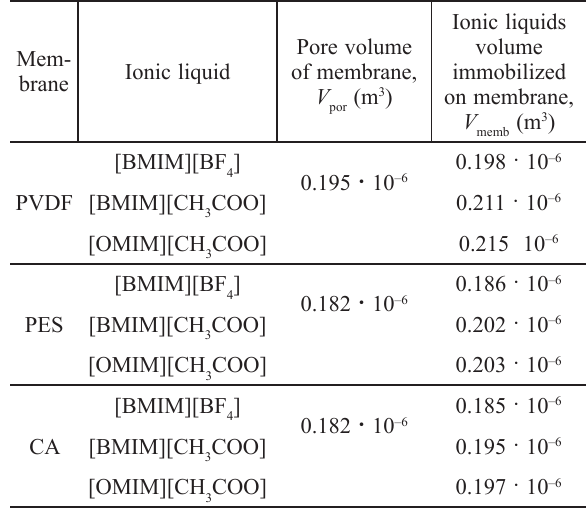
Pore volume of membrane, V (m 3 por